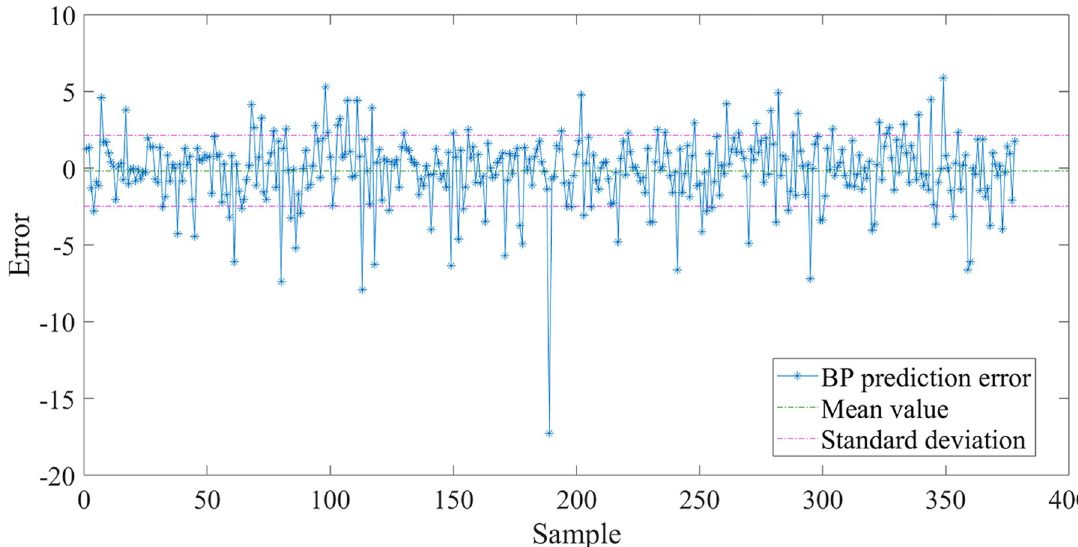
Fig 5. Prediction error analysis of BP neural